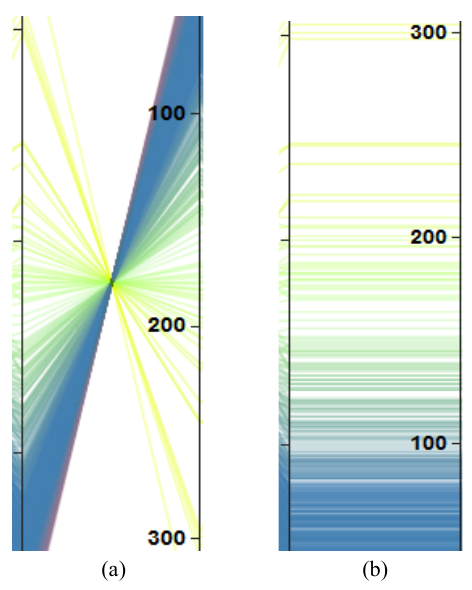
Figure 3 . Visual patterns in parallel coordinates with (a) negative correlation and (b) positive